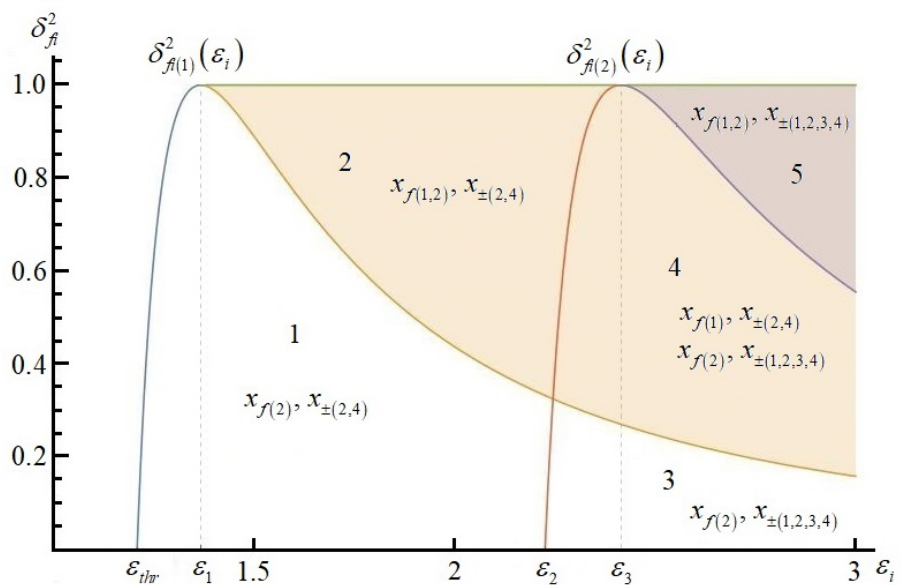
Figure 5. The dependencies of the critical angles δ fi ( 1 ) ( ε i ) , δ fi ( 2 ) ( ε i ) (see Expressions (33) and (35)) on the energy of the initial electron and the regions in ( ε i , δ 2 particles energies allowed in them (see Conditions